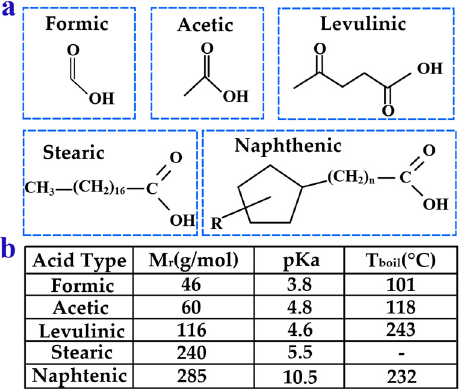
Figure 10. Structures and characteristics of five typical organic acids.